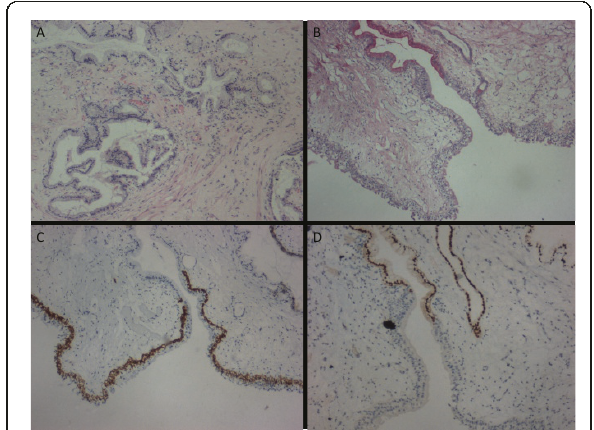
Figure 1 Histologic findings of the transurethral resected bladder tissue . (A) Endocervicosis showing round to branched endocervical-like glands with surrounding smooth muscle in the bladder (H + E × 40). (B) Surface mucinous epithelium delineated from urothelium (Southgate ’ s mucicarmine x 40). (C) CK5/6 decorating basal cells of urothelium while surface mucinous epithelium is immunonegative (x 40). (D) Nuclear ER immunopositivity is noted in the surface mucinous epithelium and adjacent endocervicosis gland (x